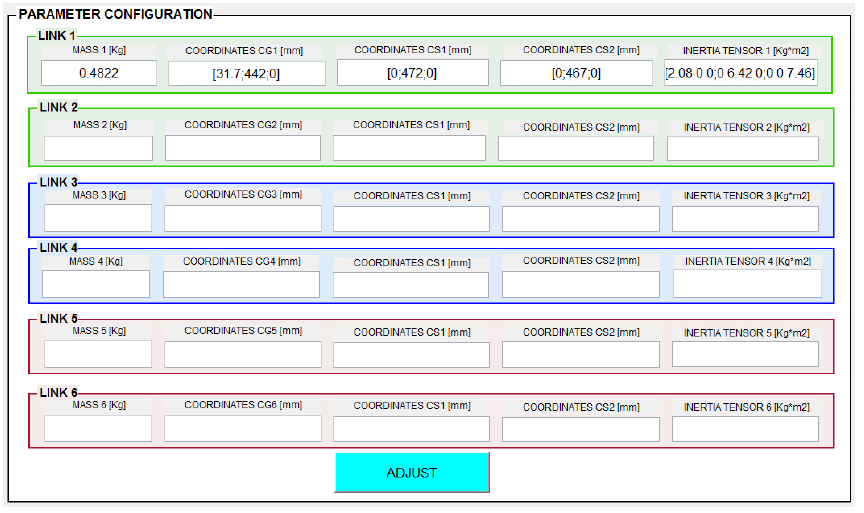
Figure 7. Configuration of the 6-DoF redundant planar manipulator robot parameters.